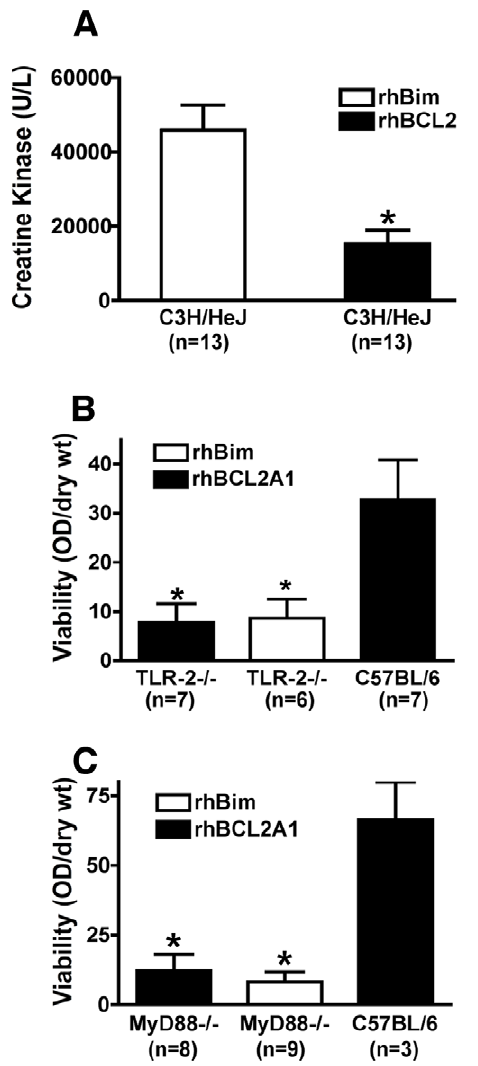
Figure 6. Protection of hind limb skeletal muscle from I/R Injury requires TLR2-MyD88 but not TLR4 signaling. (A) C3H/HeJ (TLR4 mutant) mice were pretreated with rhBCL2 (1 m g/mouse ip) or rhBim (1 m g/mouse ip) on the day prior to I/R. Mice were subjected to 90 minutes of hind limb ischemia by tourniquet, followed by 3 hours of reperfusion. CK levels in the plasma from mice were reduced by pretreatment with rhBCL2 (* p , 0.05). (B)(C) C57BL/6, TLR2 2 / 2 or MyD88 2 / 2 mice were pretreated with rhBCL2A1 or rhBim given subcutaneously (1 m g/mouse) at the time of reperfusion. Tissue viability was assessed after 90 minutes of hind limb ischemia by tourniquet and 24 hours of reperfusion. Tissue viability in TLR-2 2 / 2 (B) and MyD88 2 / 2 (C) mice treated with rhBCL2A1 or rhBim was reduced compared to C57BL/6 mice treated with rhBCL2A1 (* p , 0.05).